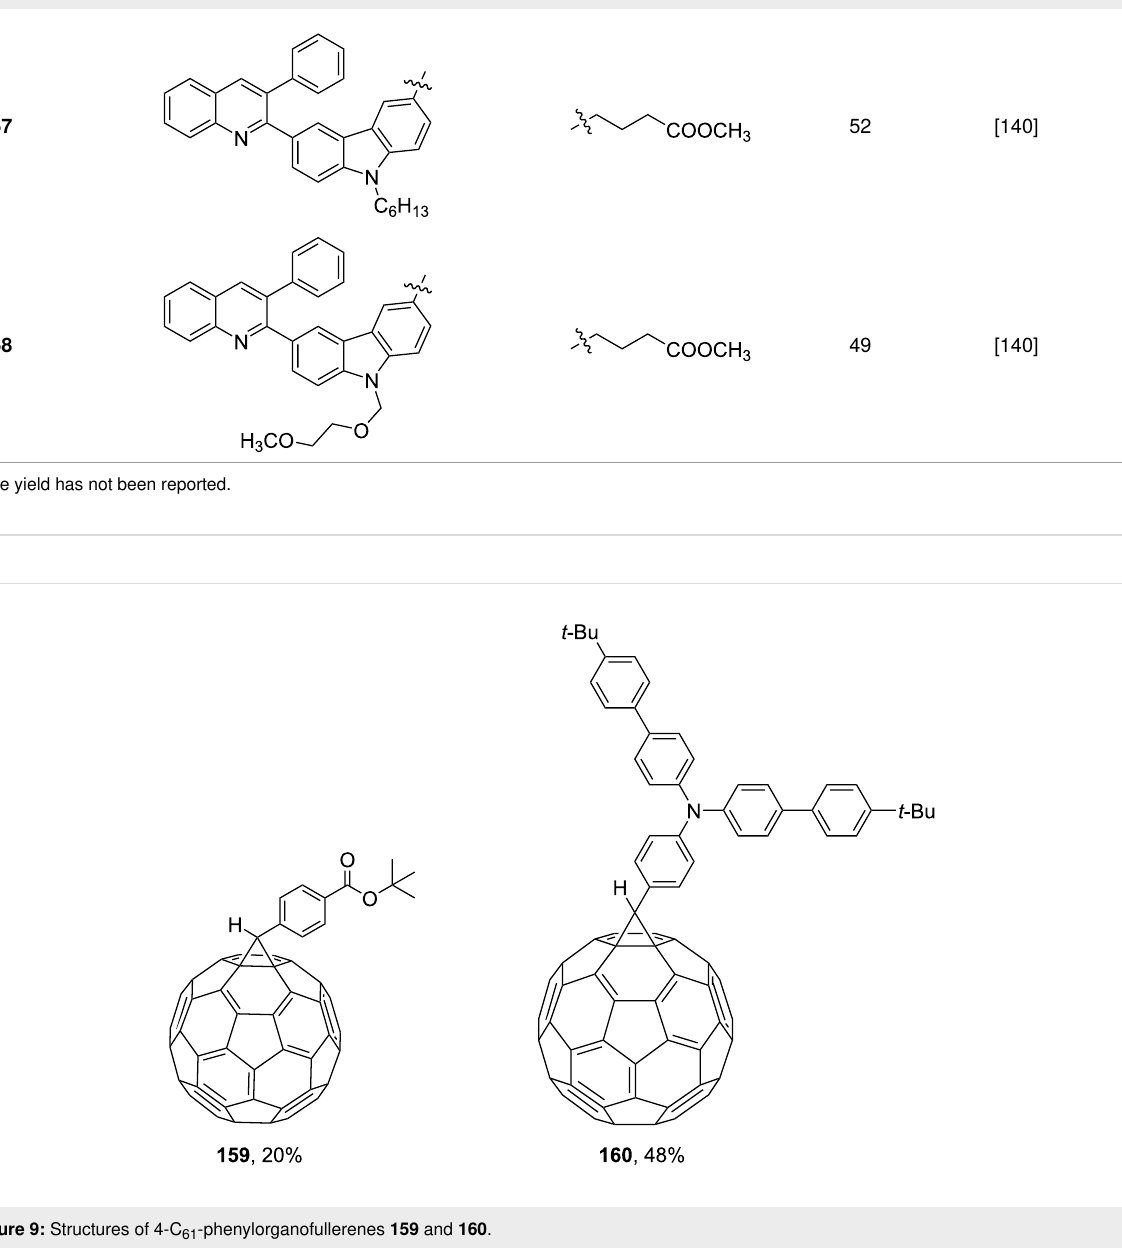
Table 1: [60]PCBM derivatives containing various aromatic and alkyl groups bound to the C 60 core. (continued)